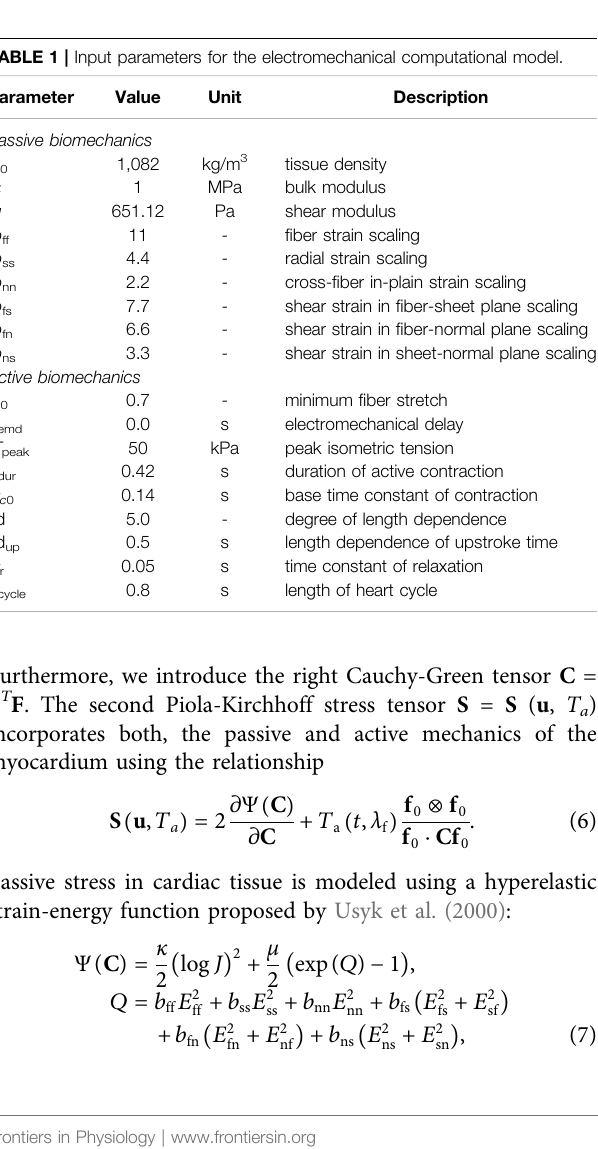
with the directional components of the Green- Lagrange strain tensor E (cid:2) 1